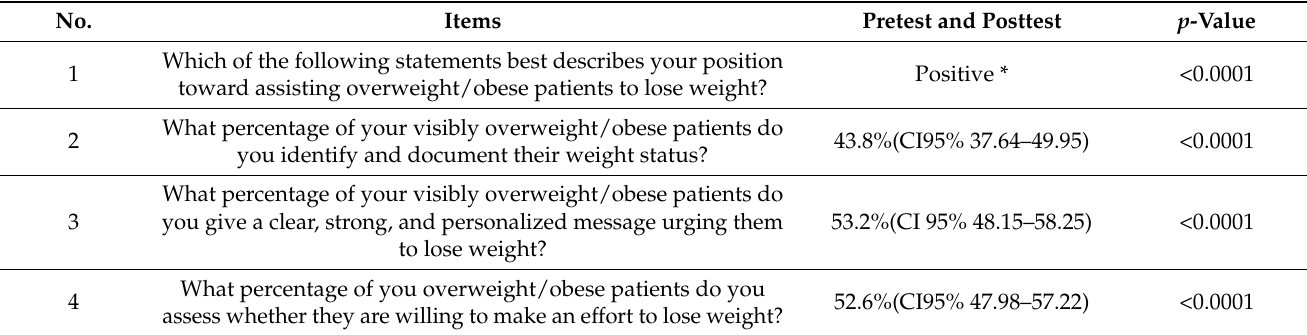
Table 1. Item Analysis of Obesity Management Knowledge and Practices ( n =